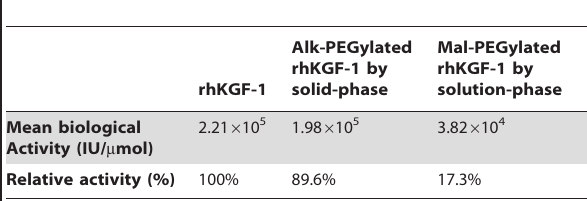
Table 1. Biological activity of native rhKGF-1 and PEGylated